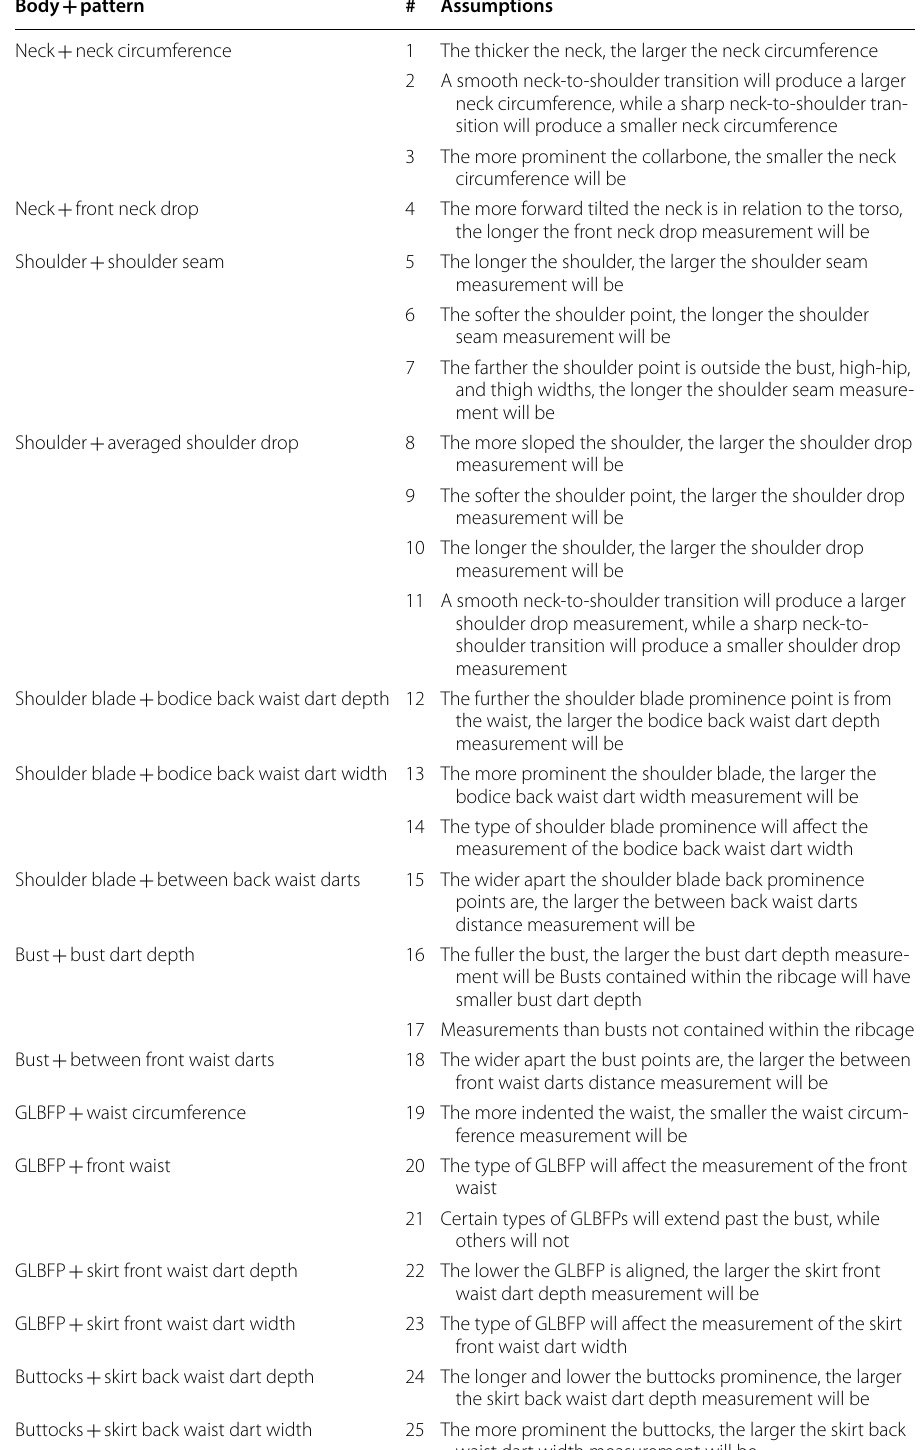
Table 4 Assumptions organized by body component and pattern dimension combinations Body +